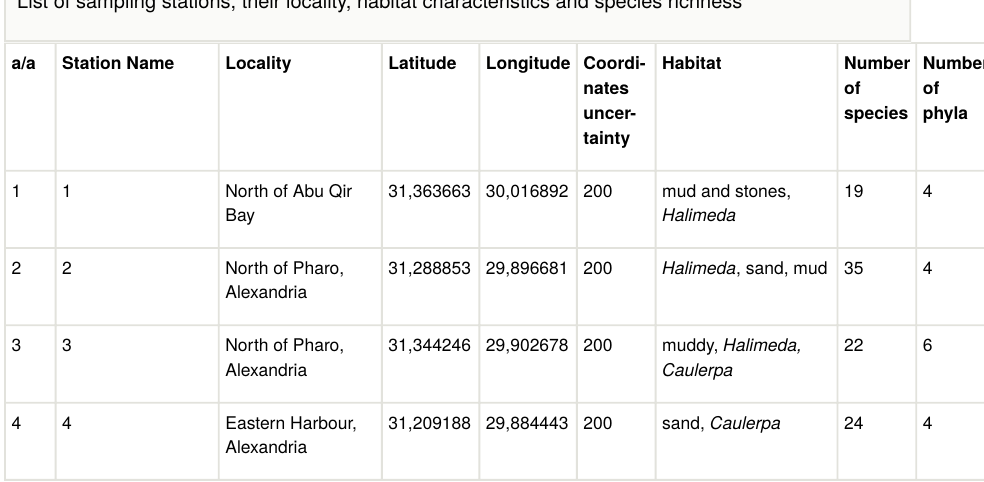
List of sampling stations, their locality, habitat characteristics and species